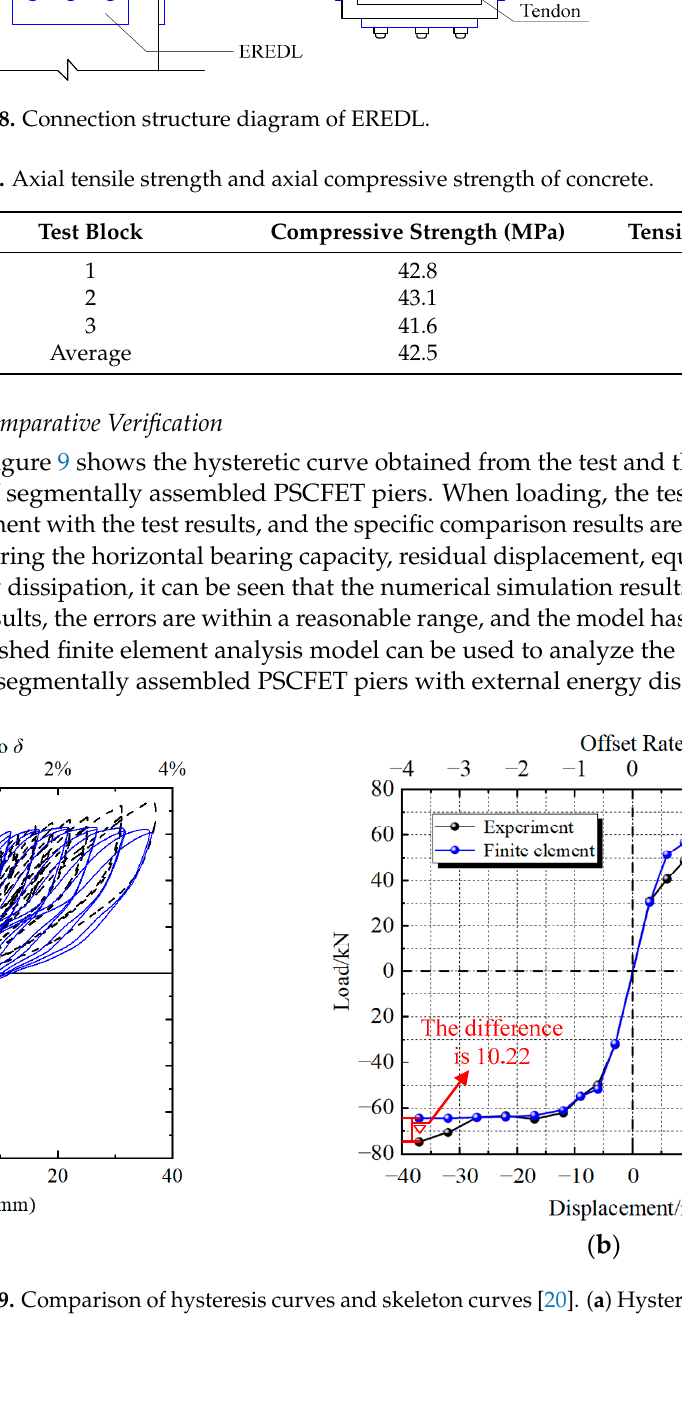
Figure 9. Comparison of hysteresis curves and skeleton curves [20]. ( a ) Hysteresis curve. ( b ) Skele- ton curve.